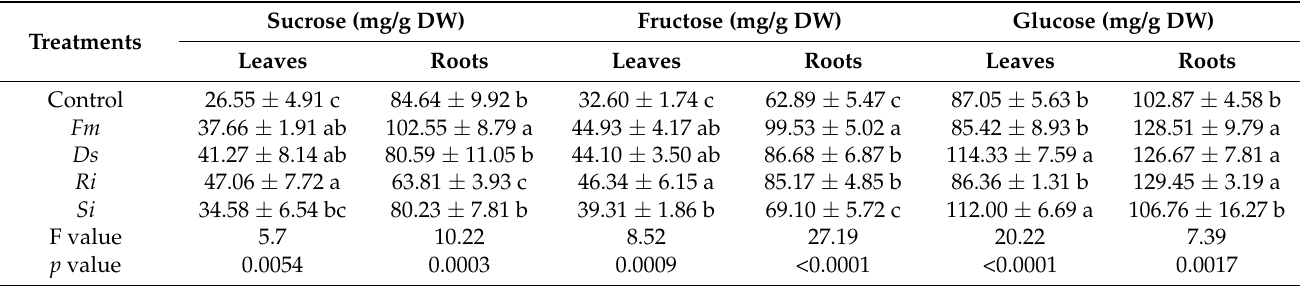
Table 3. Effects of inoculation with symbiotic fungi on leaf and root sugar fractions of Vicia villosa .